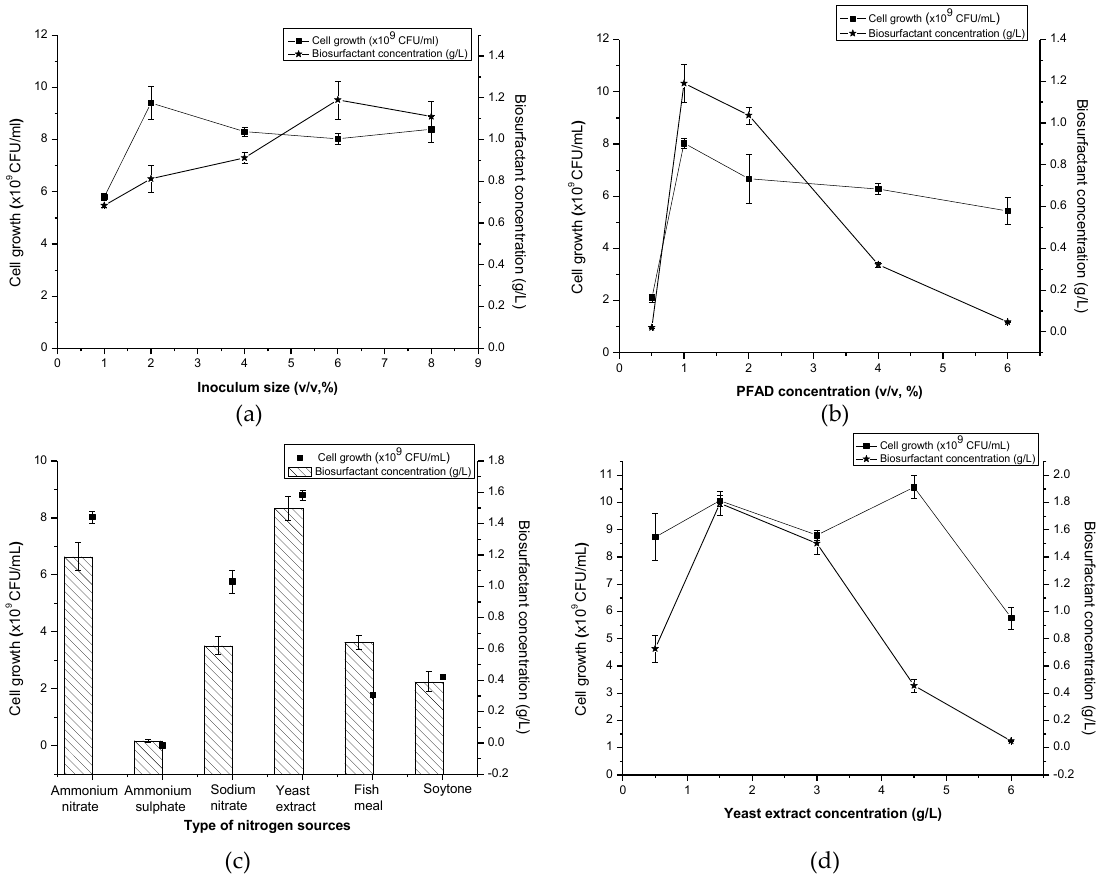
Figure 1. Effect of a) inoculum size; b) PFAD concentration; c) type of nitrogen sources; and d) yeast extract concentration on cell growth and biosurfactant concentration by Pseudomonas sp. LM19